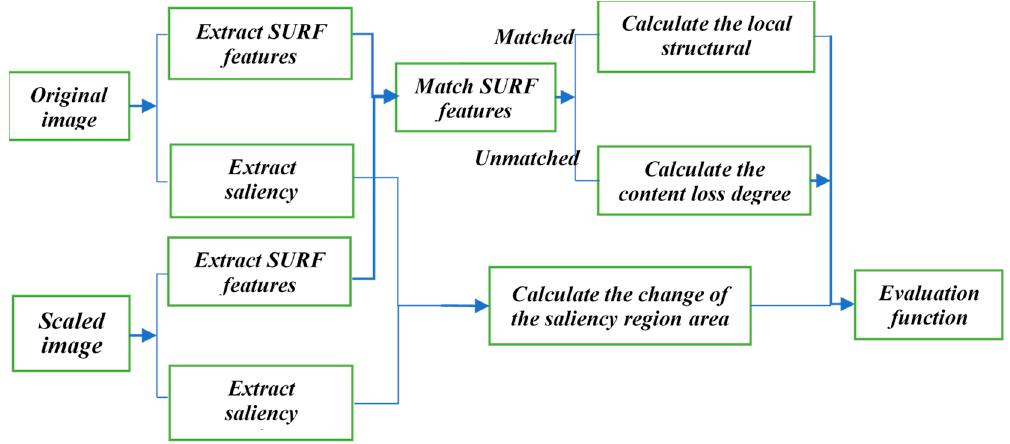
Figure 1. Schematic diagram of the image quality evaluation method.